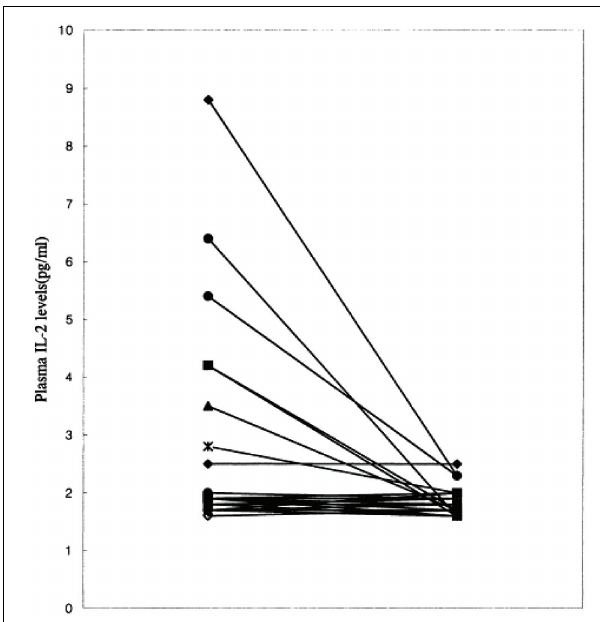
FIGURE 8 | Iinterleukin-2 levels normalize after 8 weeks of treatment in schizophrenic patients (Kim etal., 2000).